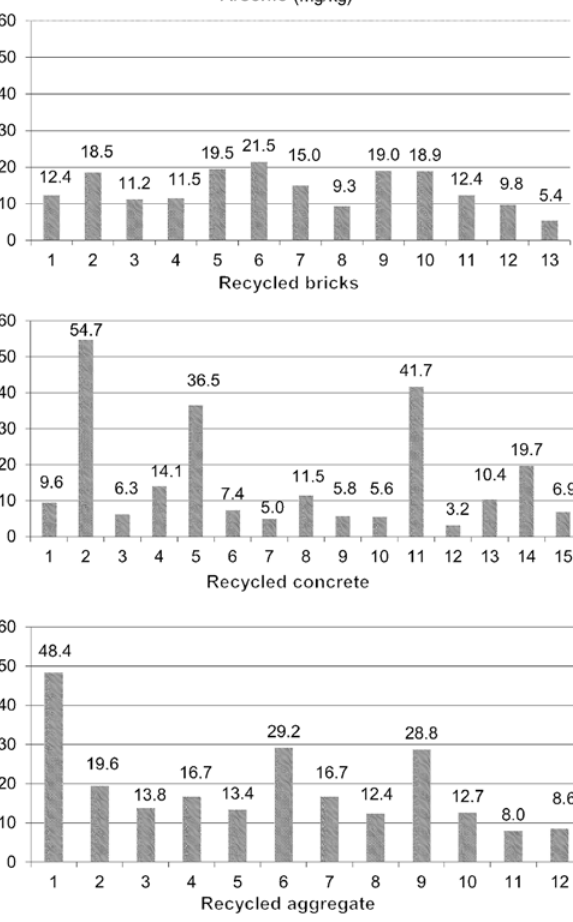
Figure 2: Amount of arsenic in tested samples.